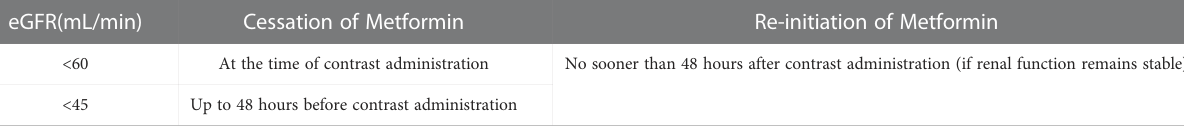
TABLE 1 Association between renal function status and duration of metformin administration.